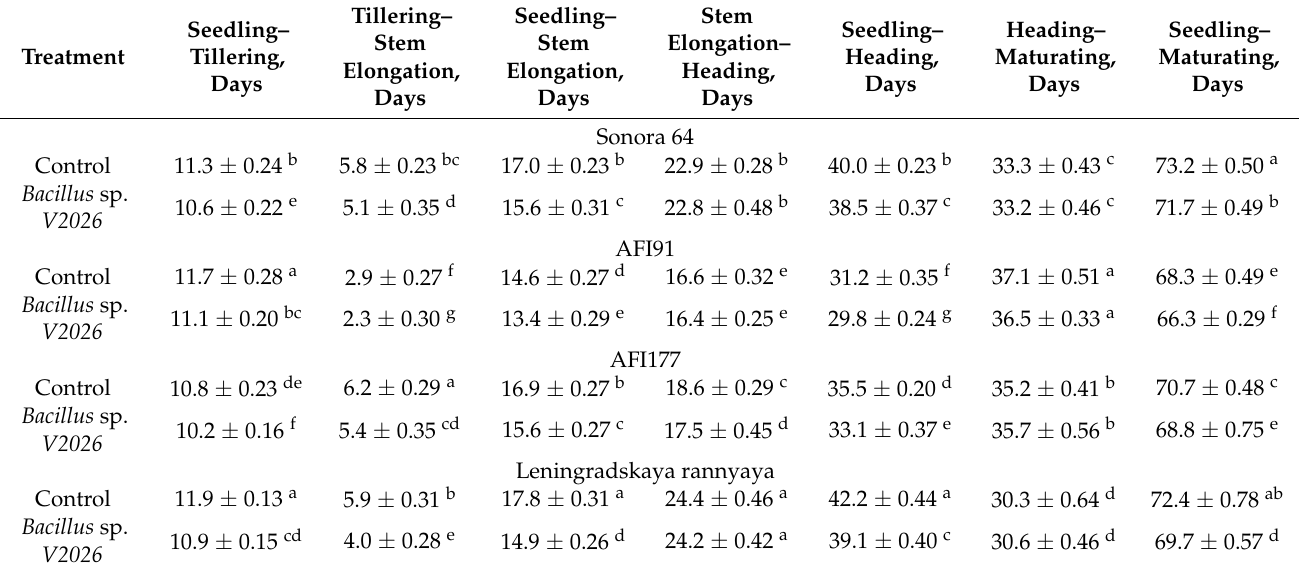
Table 3. Effect of inoculation with Bacillus sp. 2026 on the duration of developmental phases of early-maturing spring